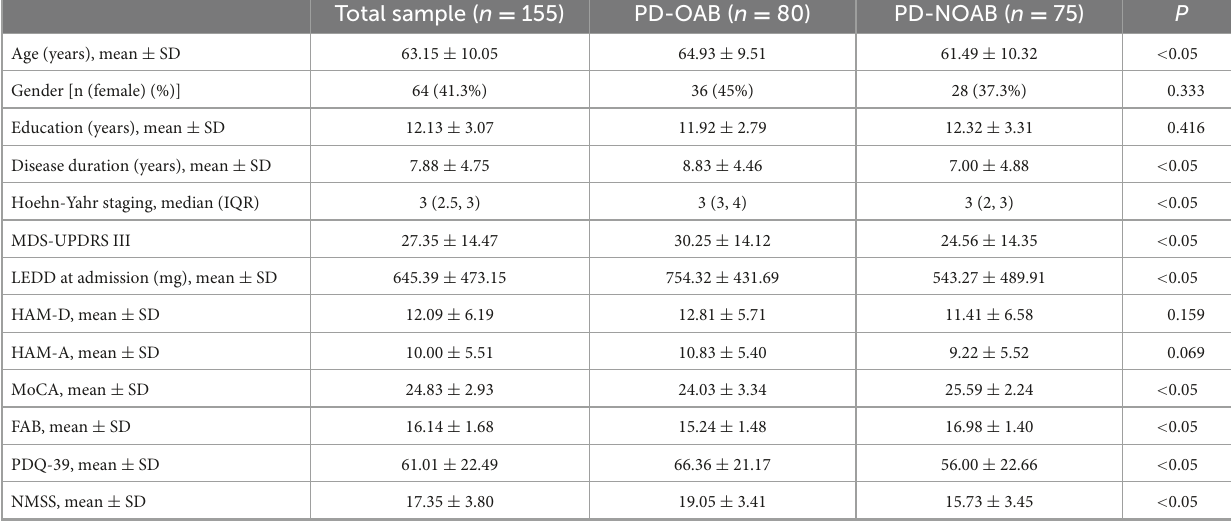
TABLE 1 Comparisons of demographic and clinical features of PD subjects with or without OAB.